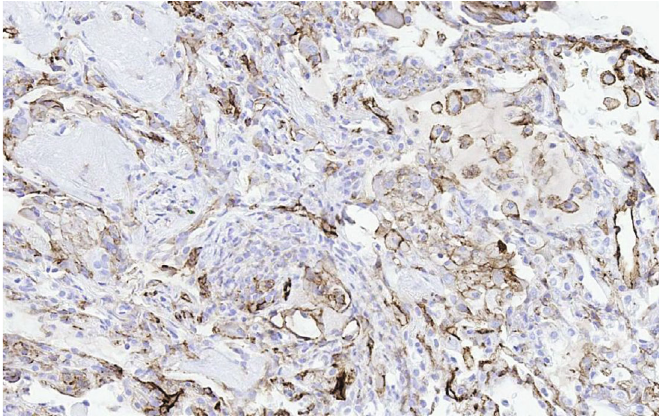
Figure 4: Immunohistochemical stain showing uptake of